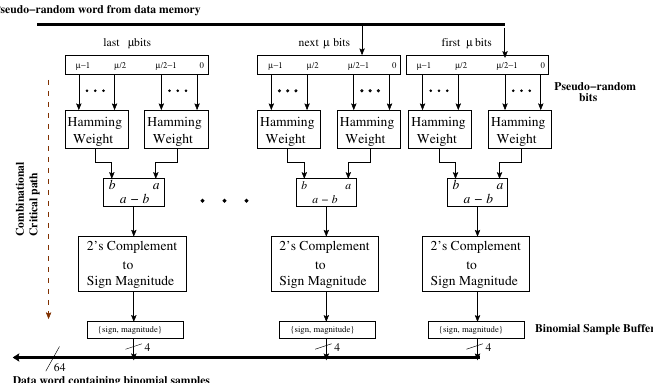
Figure 3: Binomial samplers in parallel. Output samples are stored as 4-bit sign-magnitude